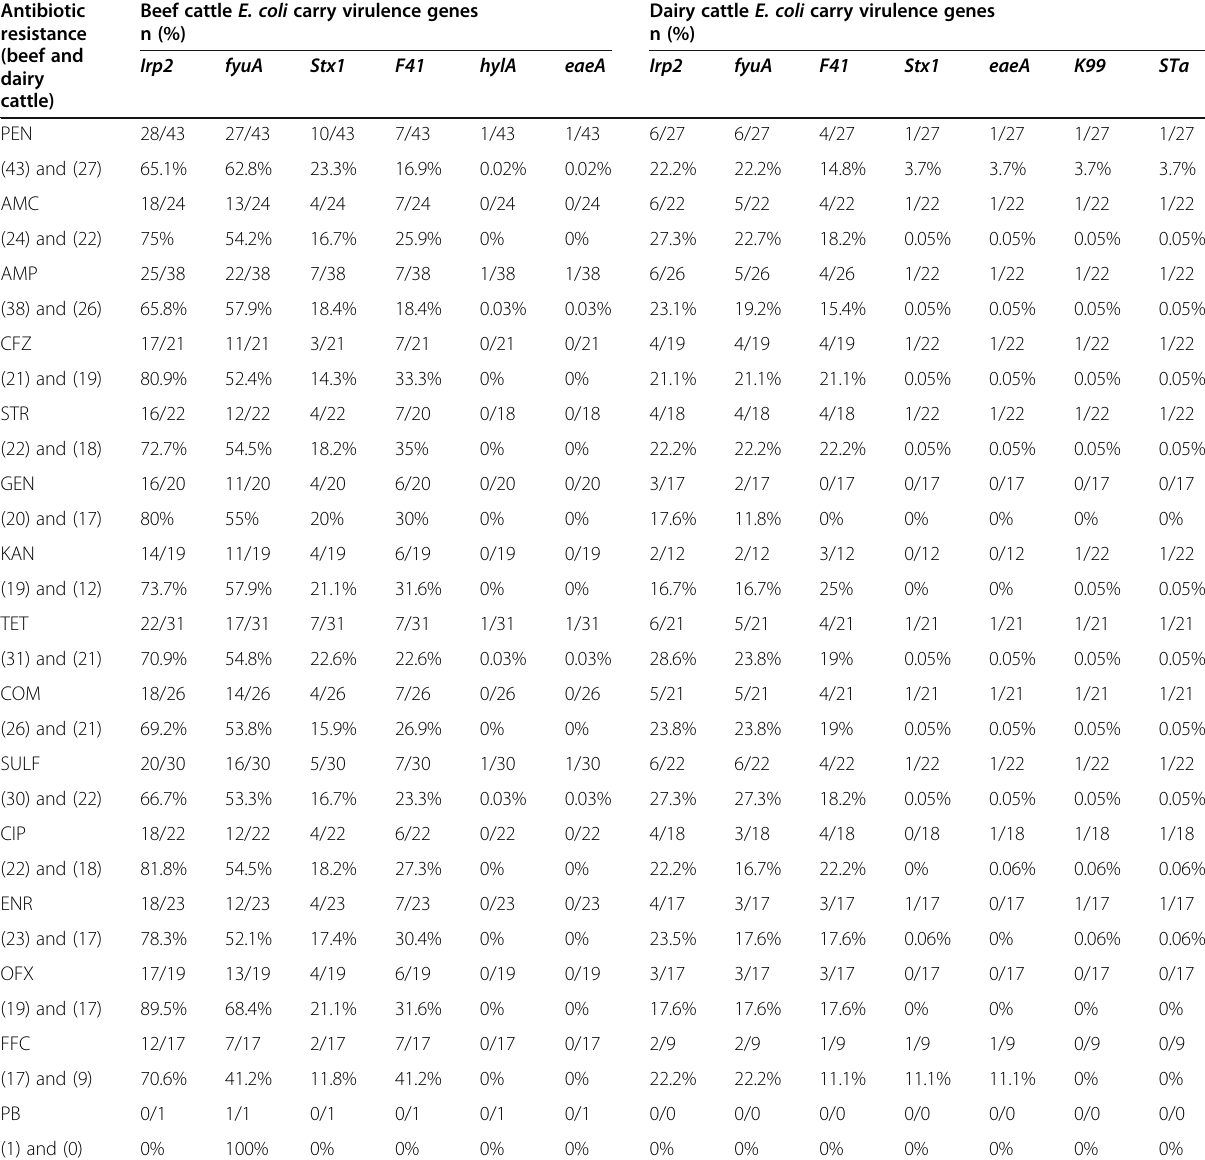
Table 7 Frequency of virulence genes among antibiotic-resistant E. coli isolates Antibiotic resistance (beef and dairy